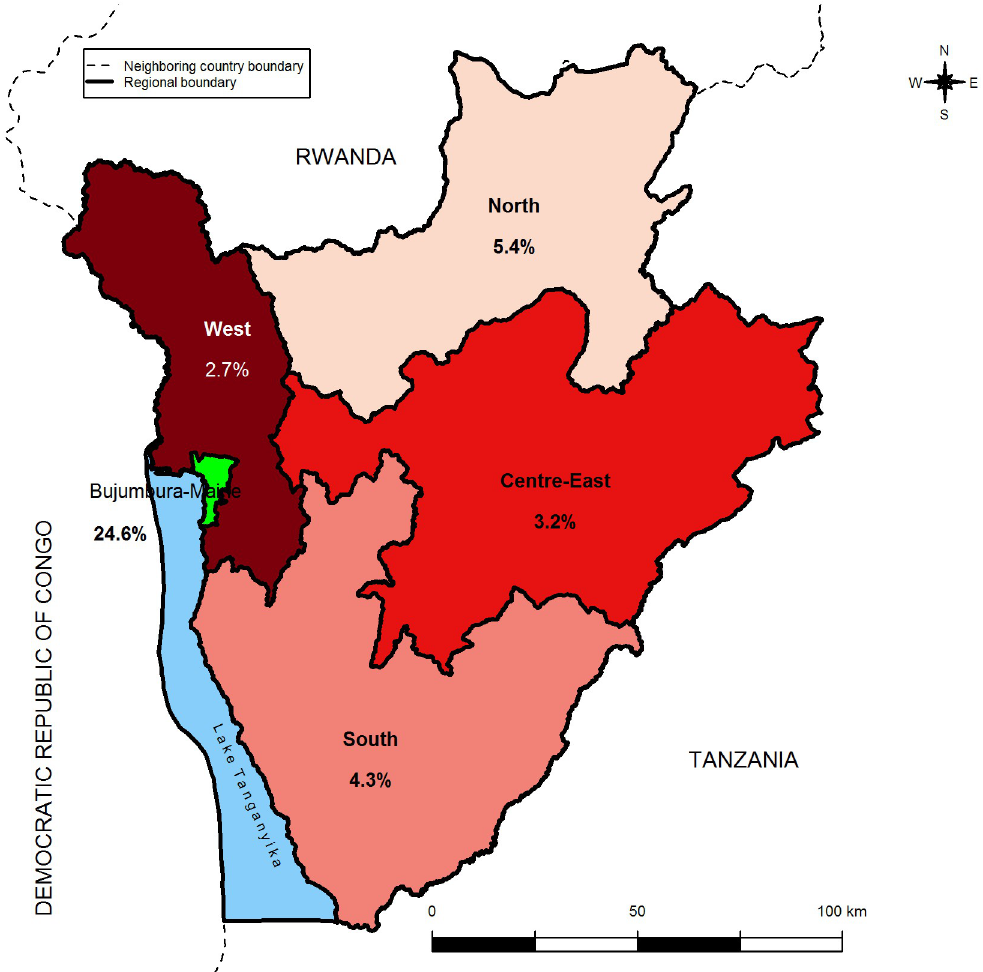
Fig 2. Distribution of regional ANC prevalence for women aged 15–49